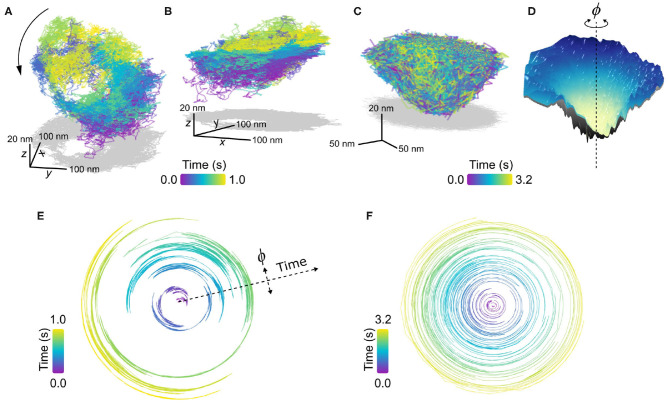
Confinement into bowl/pit-like on the plasma membrane. (A,B) Trajectory of a confined EGFR-GNP on a HeLa cell displaying a tilted “bowl” or “pit”-like morphology, as seen from two perspectives. The trajectory was recorded at 20,000 fps for 1.0 s. Gray plots represents the 2D projection. (C) A second exemplary trajectory of a pit-like confinement, recorded at 30,000 fps for 3.2 s on a COS-7 cell. (D) An interpolated smooth surface of elucidating the pit topology from (C), with the center of rotation marked with a dashed line. (E) Angular trajectory of the EGFR-GNP about the center of the bowl from (A), where the radial position denotes time. (F) Angular trajectory of the EGFR-GNP about the center of the bowl from (C).